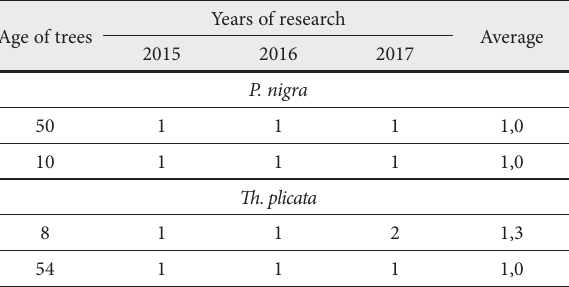
Evaluation of winter tolerance of P. nigra and Th. plicata of different age periods (in points)